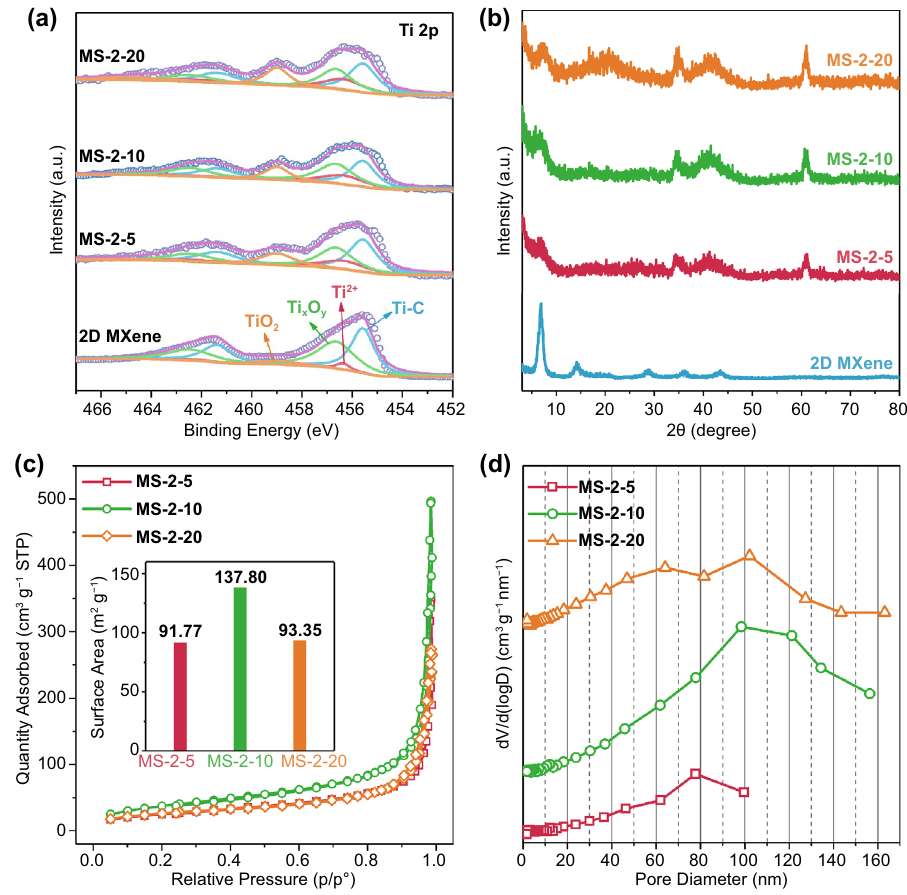
Fig. 2 a Ti 2p XPS spectra and b XRD patterns of 2D MXene, MS-2-5, MS-2-10, and MS-2-20. c N 2 adsorption–desorption isotherms and d pore size distribution of MS-2-5, MS-2-10, and